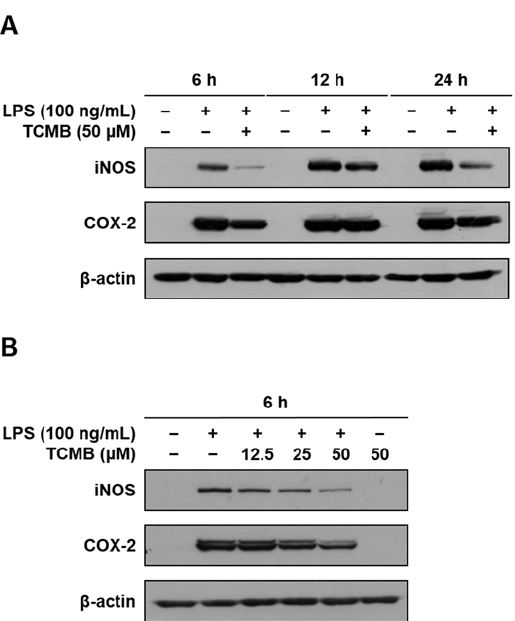
Figure 4. Effects of TCMB ( 11 ) on the protein level of iNOS and COX ‐ 2 in LPS ‐ stimulated RAW 264.7 macrophages. The cells were pretreated with TCMB ( 11 ) at a concentration of 50 μ M for the indicated time and then stimulated with LPS (100 ng/mL) ( A ). The cells were treated with TCMB ( 11 ) at concentrations of 12.5, 25, and 50 μ M for 6 h and then stimulated with LPS (100 ng/mL) ( B ). The protein expression of iNOS and COX ‐ 2 was estimated by Western blotting using specific antibodies. β‐ actin was an internal control. 2.4. Effects of TCMB on iNOS and COX ‐ 2 mRNA Expression Levels in LPS ‐ Stimulated RAW 264.7 Macrophages To examine whether TCMB ( 11 ) affects the mRNA expression level of iNOS and COX ‐ 2, qRT ‐ PCR was performed. The relative iNOS and COX ‐ 2 mRNA expression levels were elevated by LPS treatment, while TCMB ( 11 ) treatment (12.5, 25, and 50 μ M) significantly diminished the relative LPS ‐ stimulated mRNA expression levels of iNOS and COX ‐ 2 in a dose ‐ dependent manner (Figure 5A,B).